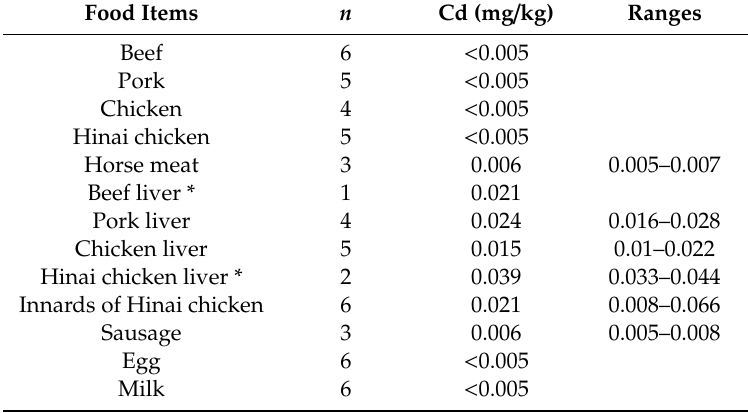
Table 8. Cadmium (Cd) concentrations in livestock food. Data are presented as arithmetic means.